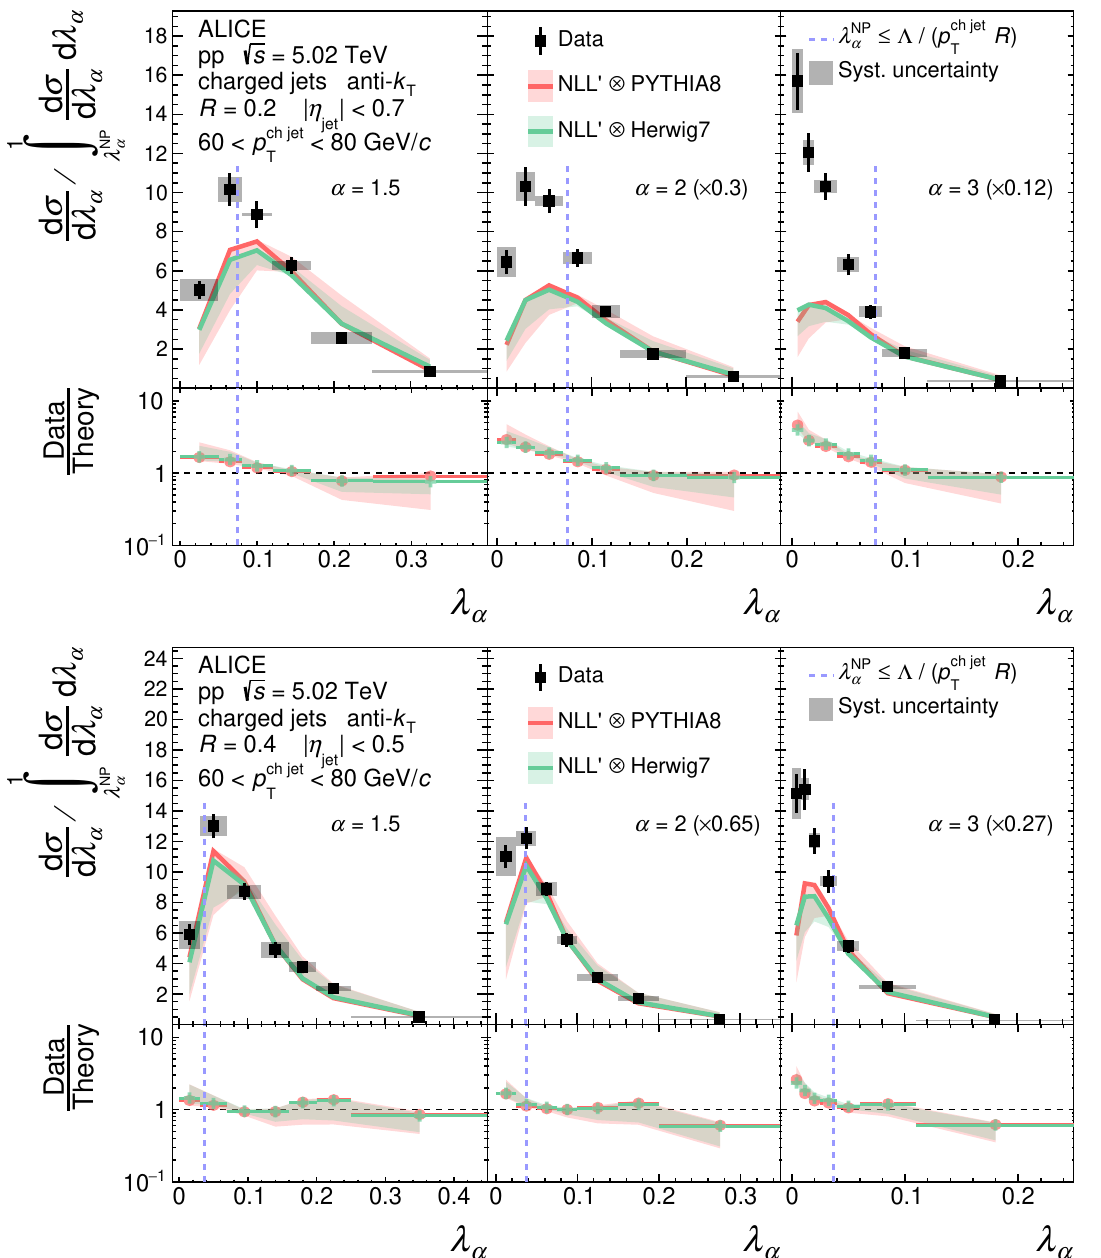
Figure 5 . Comparison of ungroomed jet angularities λ α in pp collisions for R = 0 . 2 (top) and R = 0 . 4 (bottom) to analytical NLL 0 predictions with MC hadronization corrections in the range 60 < p ch jet < 80 GeV /c . The distributions are normalized such that the integral of the perturbative T region defined by λ α > λ NP (to the right of the dashed vertical line) is unity. Divided bins are α placed into the left (NP)